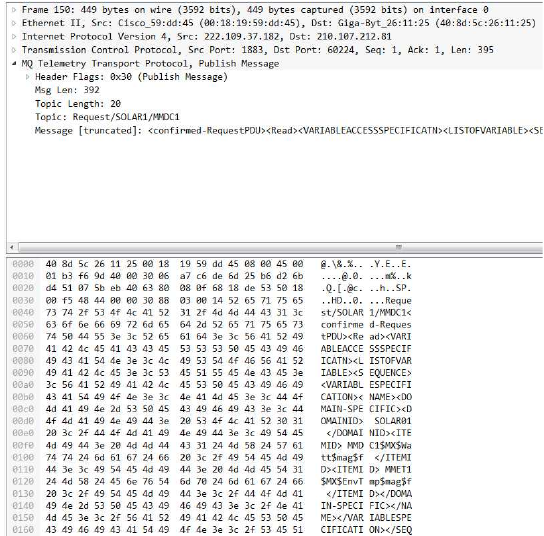
Figure 13. Packet captured from the DMS to the MGMS request message using the MQTT.